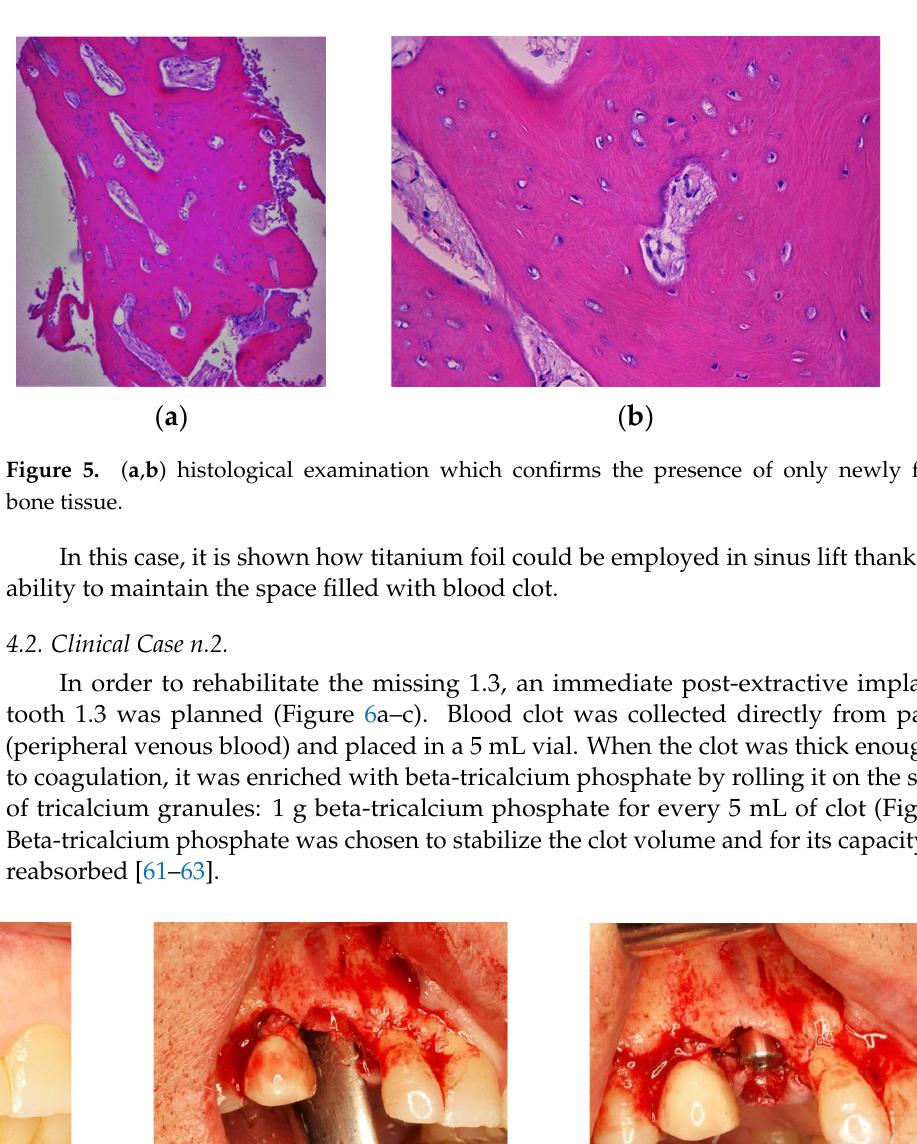
Figure 4. Foil radiographic checks: in evidence the shape of the foil.